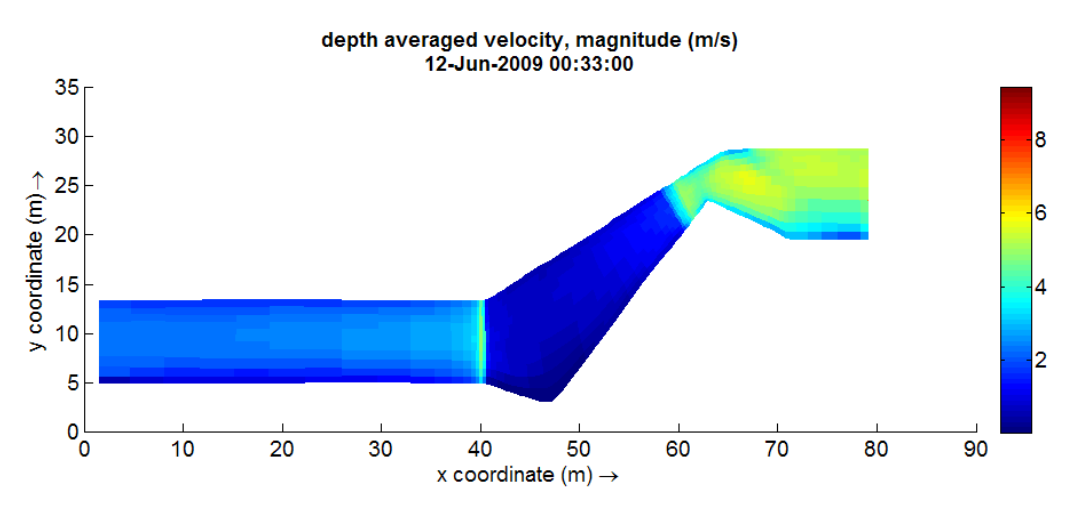
Figure 12. Velocity magnitude variation in the flow system for HDS